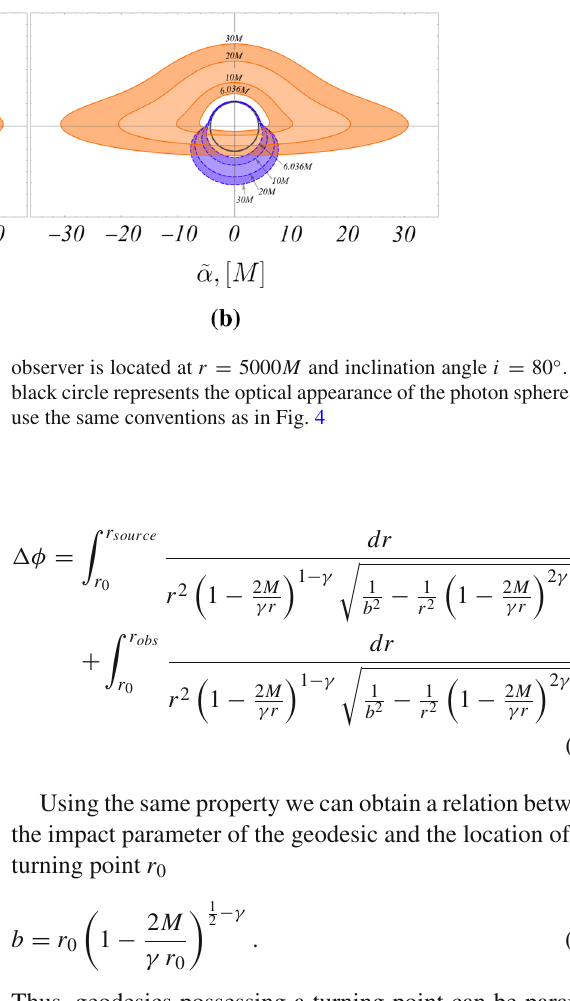
sented in black contour. The inner marginally stable orbit is located at r − = 4 . 271 M , while the outer one corresponds to r + = 5 . 896 M . The inner disk is visualized up to a small neighbourhood δ r = 10 − 10 M of the curvature singularity, which is located at r cs = 4 . 166667 M